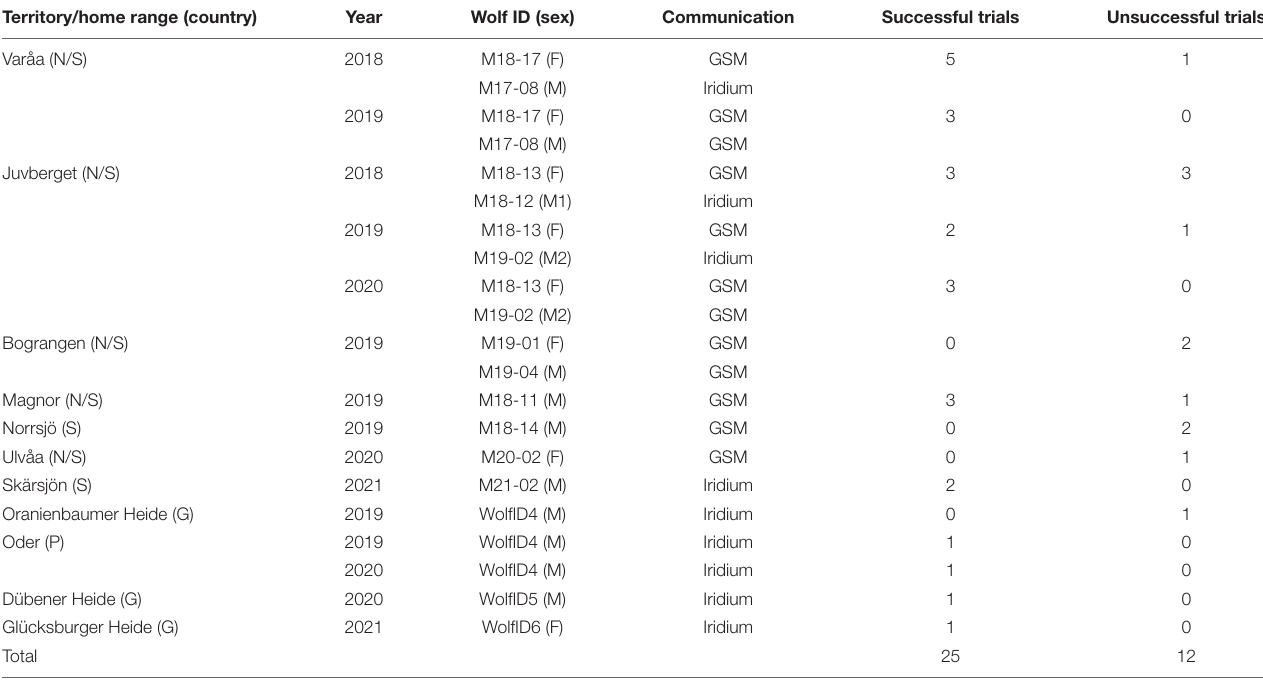
TABLE 2 | Overview of successful and unsuccessful experimental human approach trials on wild wolves in Norway (N), Sweden (S), Poland (P), and Germany (G) during 2018–2021. Territory/home range (country)